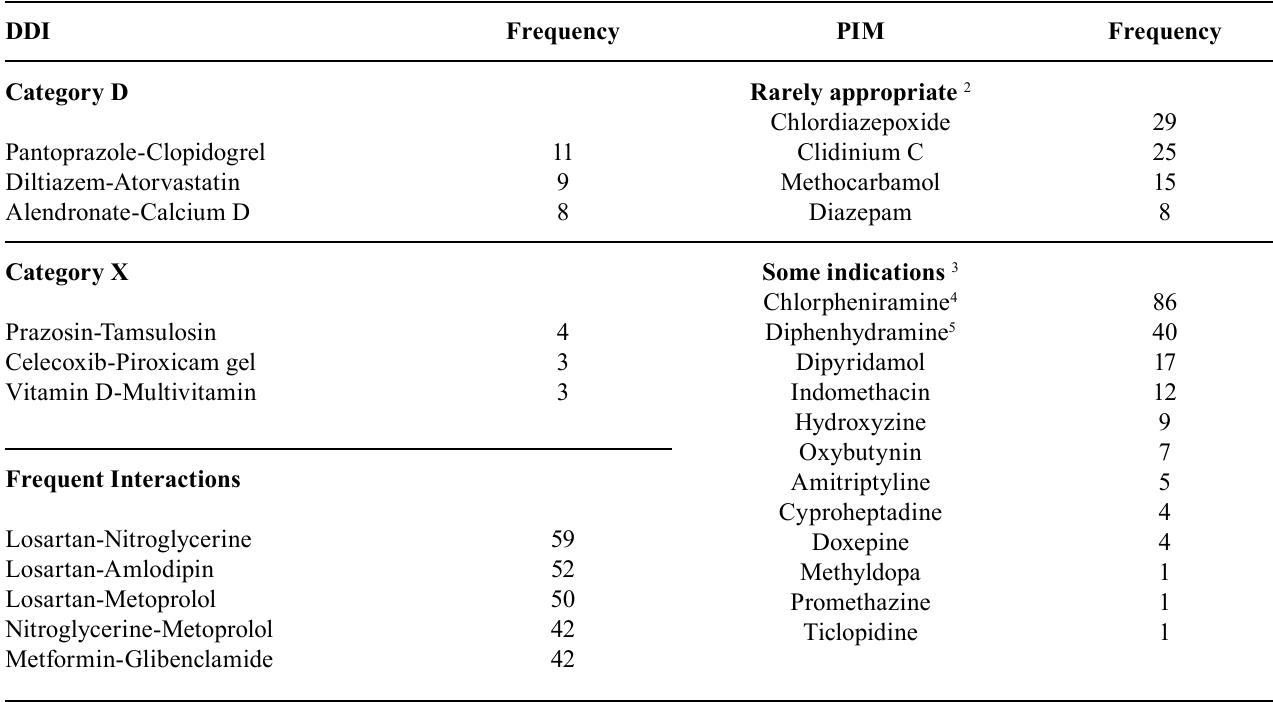
TABLE II – Frequent drug interactions within C, D and X category and frequency of potentially inappropriate medication in different Zhan categories